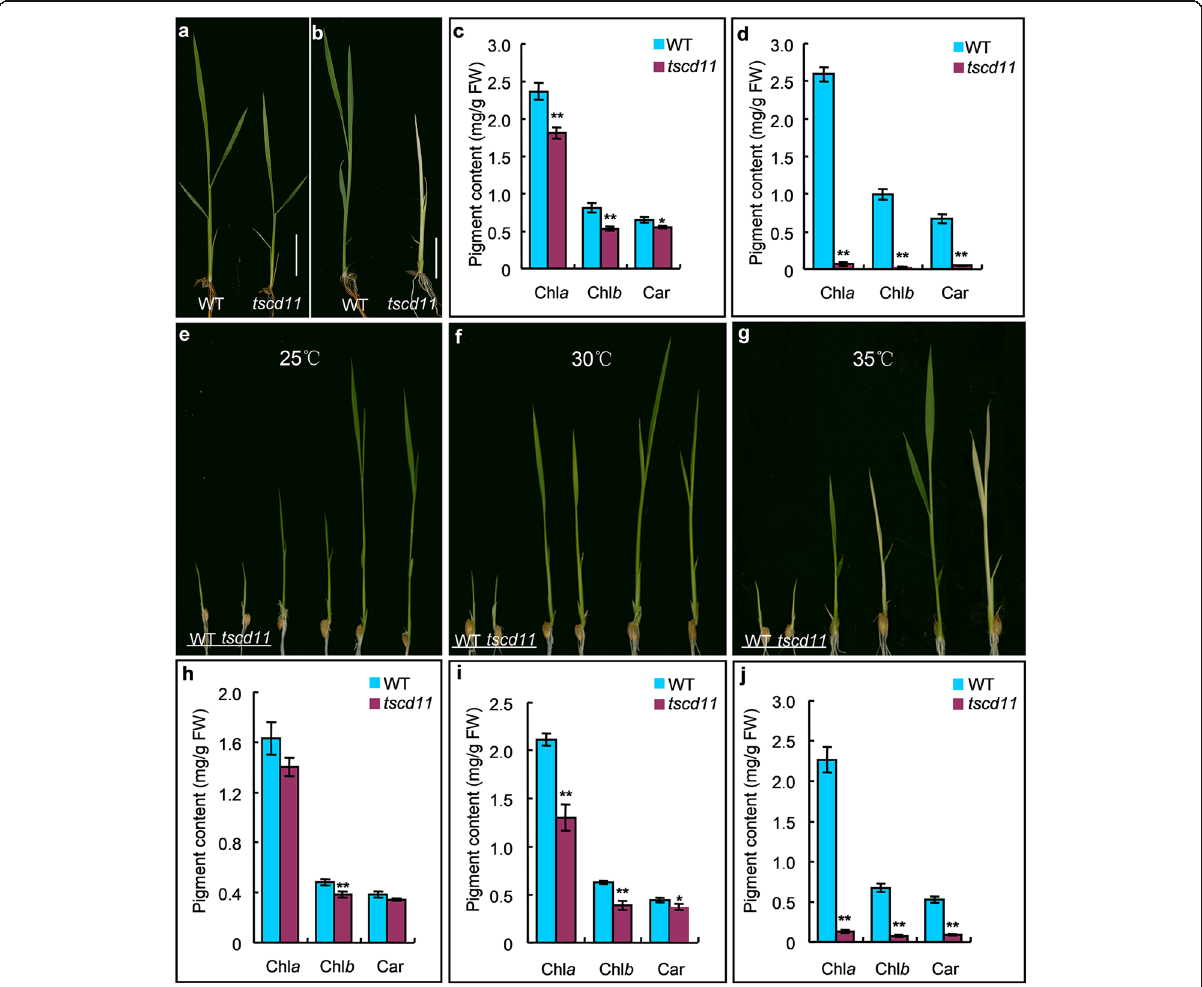
Fig. 1 Phenotypes and pigment contents comparison between wild-type and tscd11 plants. a-b Morphology of wild-type and tscd11 plants at the seedling stage sown in May and June, respectively, in the paddy field (bar = 2 cm). c-d pigment contents of WT and tscd11 at the seeding stage in May and June, respectively. e-g 1-, 2-, 3-leaf stage seedlings of the WT and tscd11 mutant grown at 25 °C, 30 °C and 35 °C, respectively. h-j Pigment contents of 3-leaf stage of the wild-type and tscd11 plants grown at 25 °C, 30 °C and 35 °C, resepectively. Chl a, chlorphyll a ; Chl b, chlorphyll b ; Car, carotenoids. Data represent mean ± SD ( n = 3). * p < 0.05, ** p < 0.01 (Student ’ s t